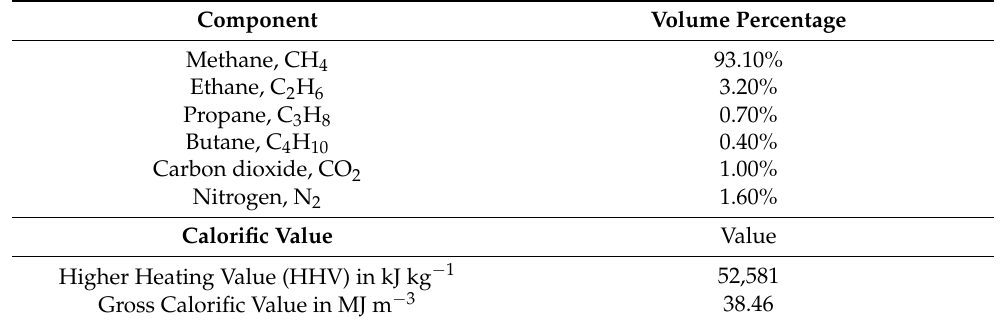
Table 2. Natural gas composition and